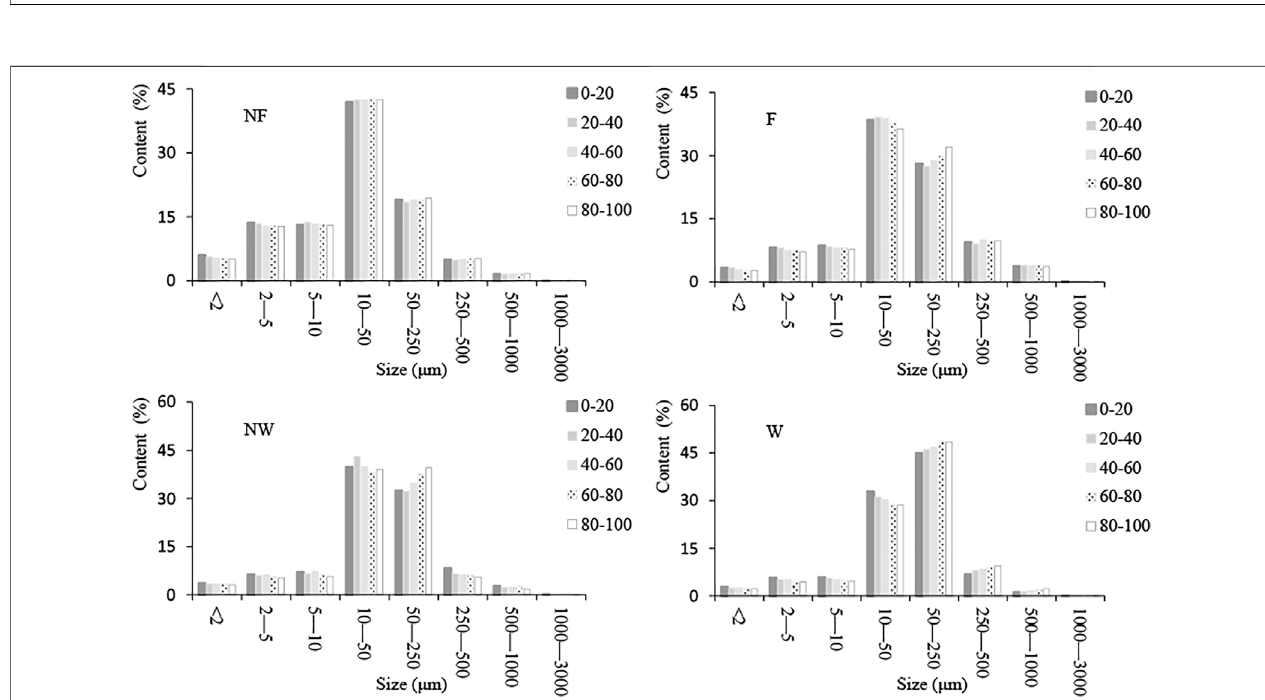
FIGURE 2 | Average content distribution of the soil particles in the soil pro fi le. (NW/NF is the woodland/farmland in the non fl ooded area, and W/F is the woodland/ farmland in the fl ooded area).